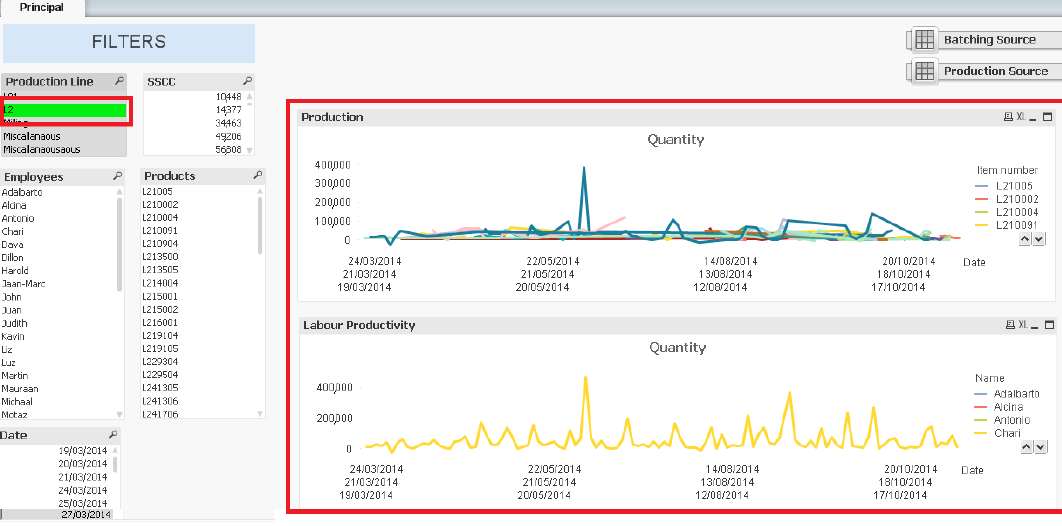
Figure 3. Comparative graph of units produced per line, employee, product, and day.